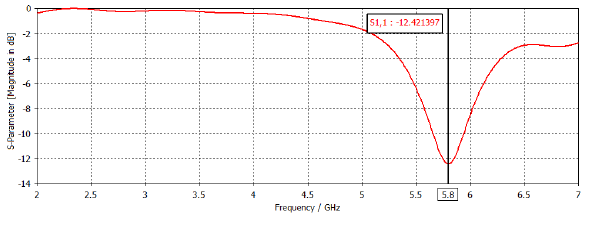
Figure 3. Return loss for FR4.